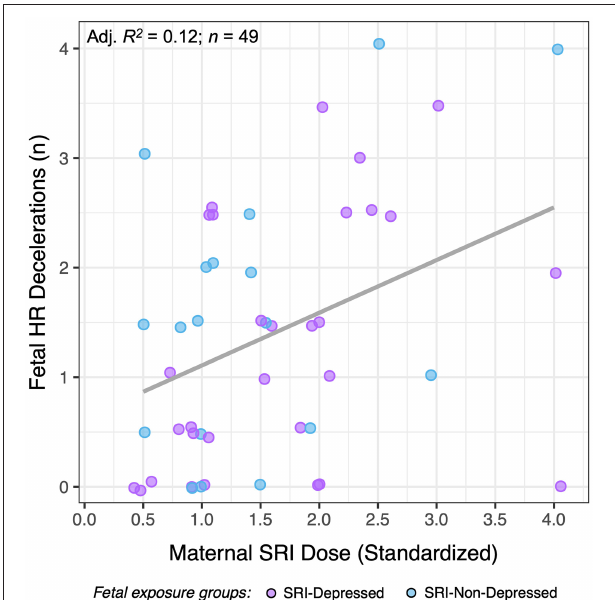
FIGURE 5 | The relationship between standardized maternal SRI oral dose and the number of fetal HR decelerations for SRI-exposed fetuses (SRI-Depressed and SRI-Non-Depressed groups). Data presented represent average HR decelerations across 50-min CTG sessions, which did not differ across